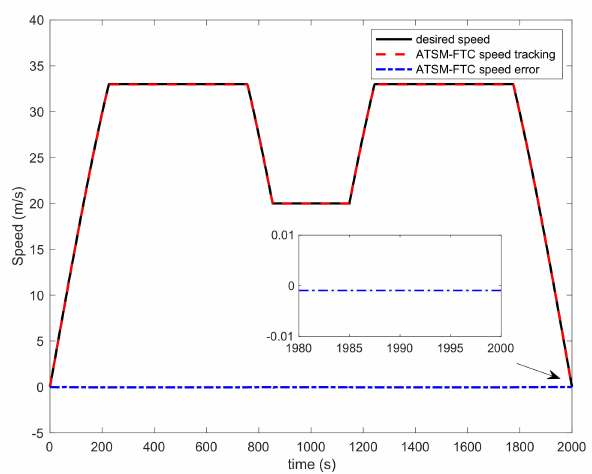
Figure 10. Speed tracking performance of